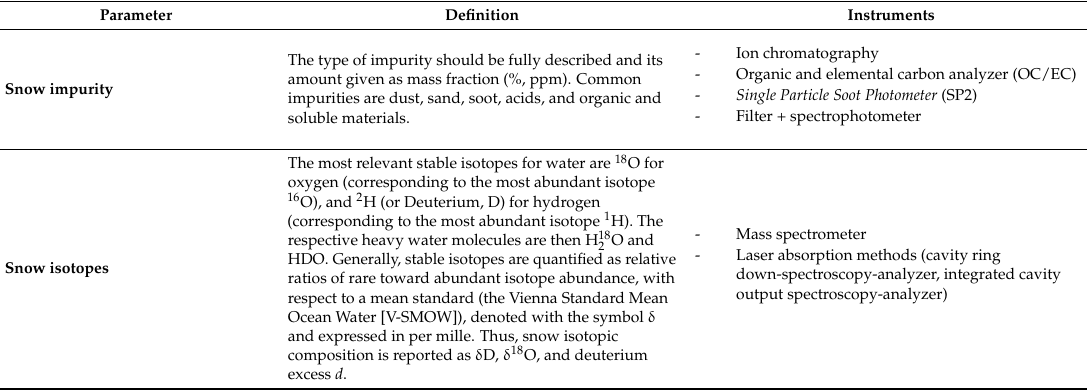
Table A5. List of measurable properties associated with snow composition: name of the properties (first column), definition (second column), and existing